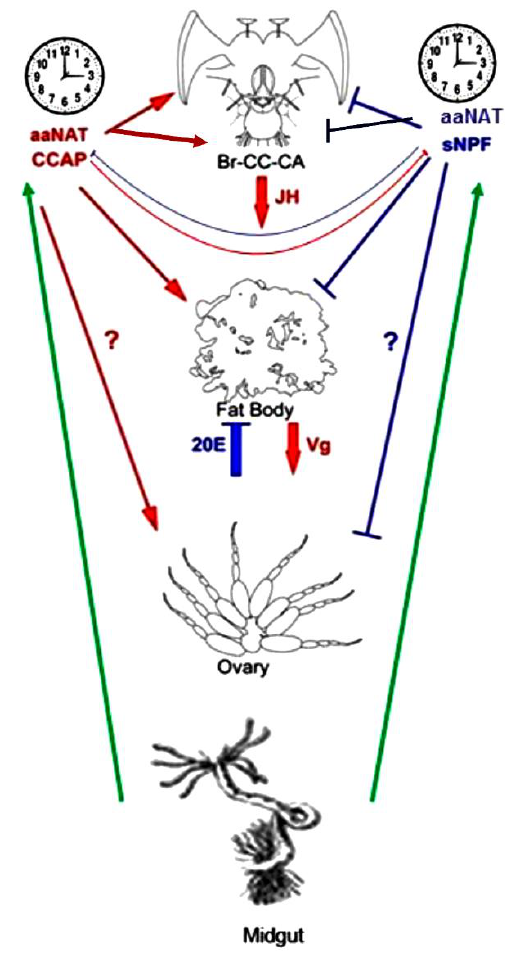
Figure 10. The “physiological wormhole model” for control of insect reproduction. Three distinct routes of neuroendocrine pathways, running in parallel or interactive or linearly connected. Probably non-endocrine regulatory pathways operate to regulate reproductive timing, associative behaviors, metabolic supports, JH/20E, CCAP/sNPF and monoamines as well as the biological clock, longevity, and cell cycle machinery.